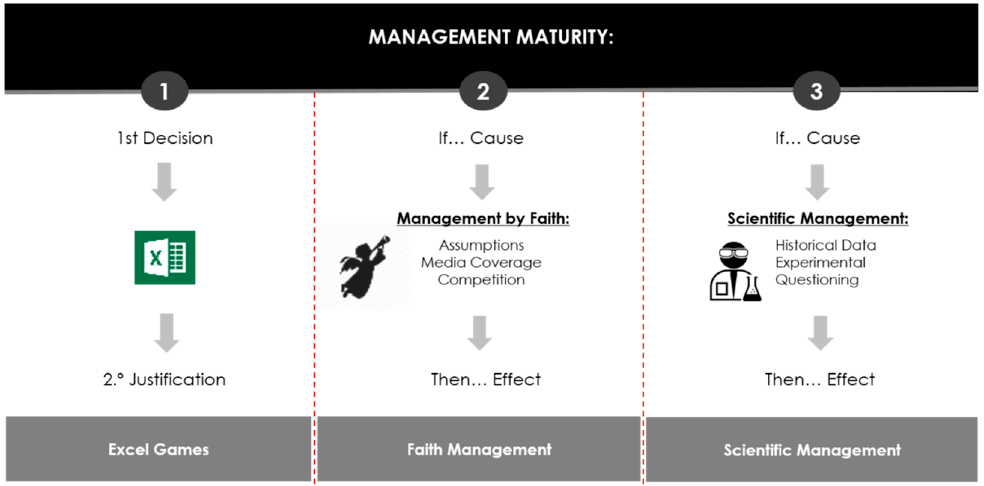
Figure 2. Management Maturity Stages (authors).